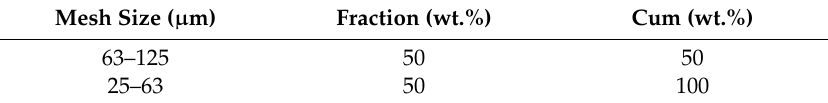
Table 6. The grain size distribution of the Carajas iron ore.